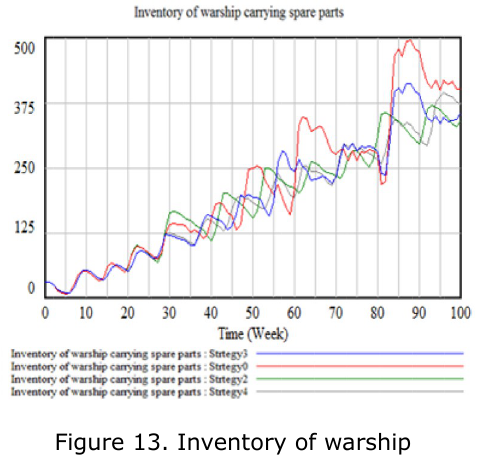
Figure 13. Inventory of warship carrying spare parts